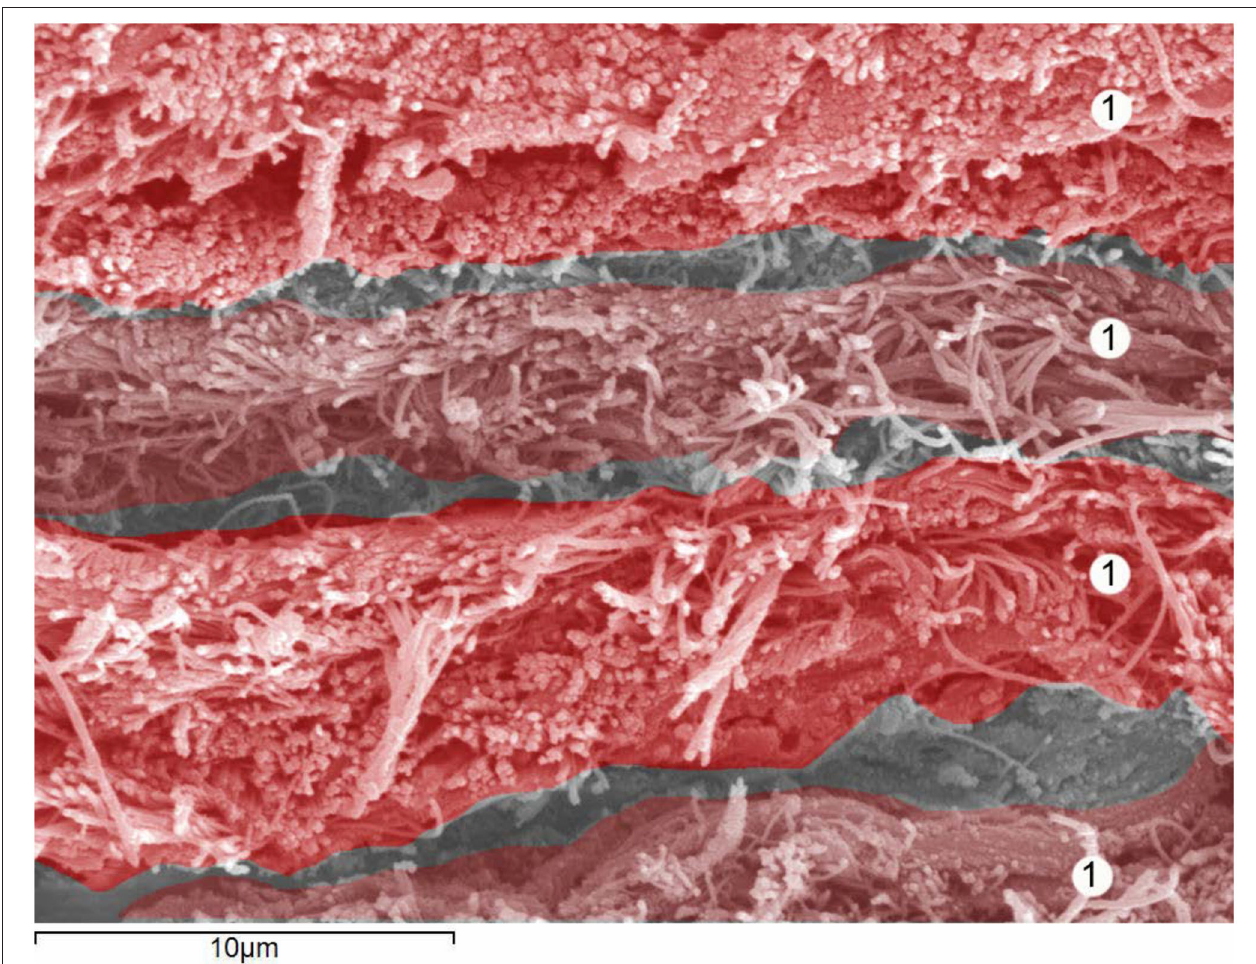
FIGURE 2 | Human dura mater. Details of 4 dural lamina. Scanning electron microscopy. Magnification × 4,000. 1 = Dural lamina. With permission of Dr. Miguel A. Reina.